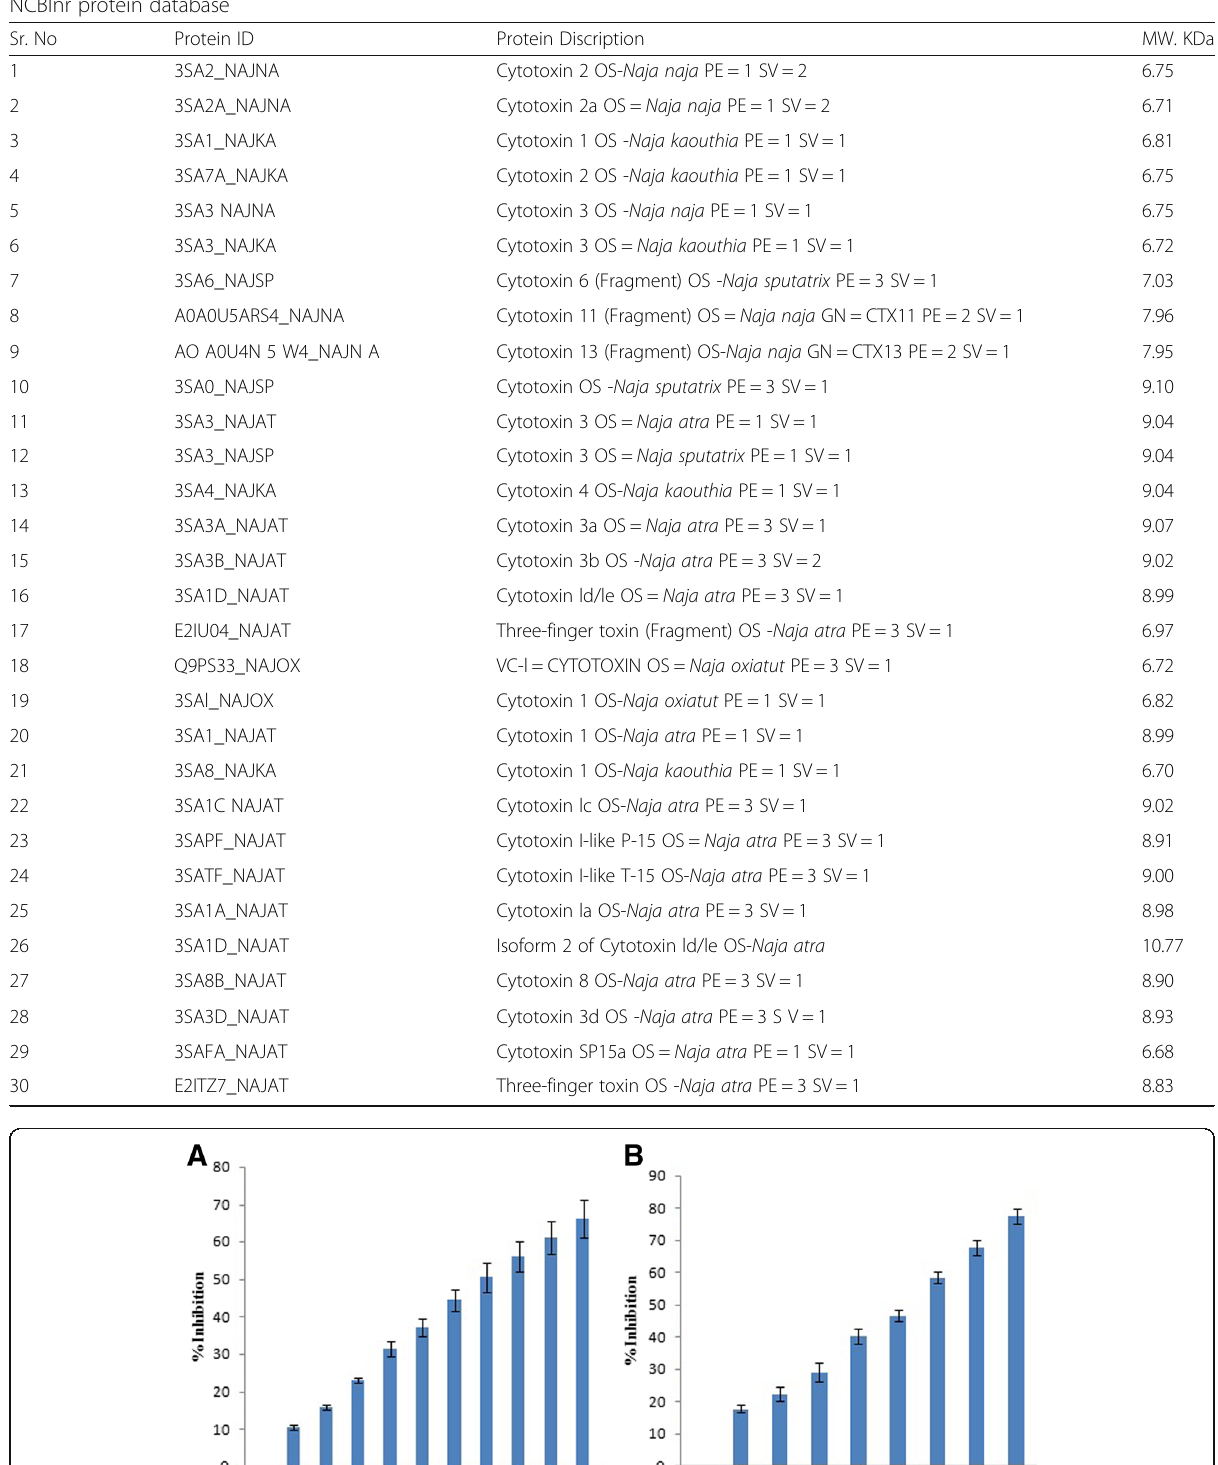
Table 1 List of toxins having homology with the NN-32 toxin, search carried out by mascot database search engine against the NCBInr protein database